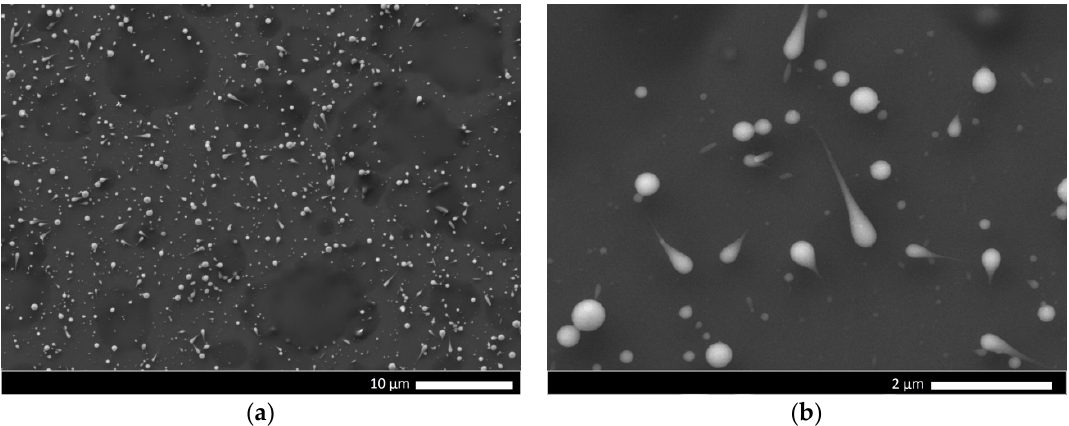
Figure 9. SEM photomicrographs of nanoparticles electrosprayed from the hyaluronic acid solutions with concentration 7.5 mg/mL under 30 kV: ( a ) magnification 4000×; ( b ) magnification 25,000×.